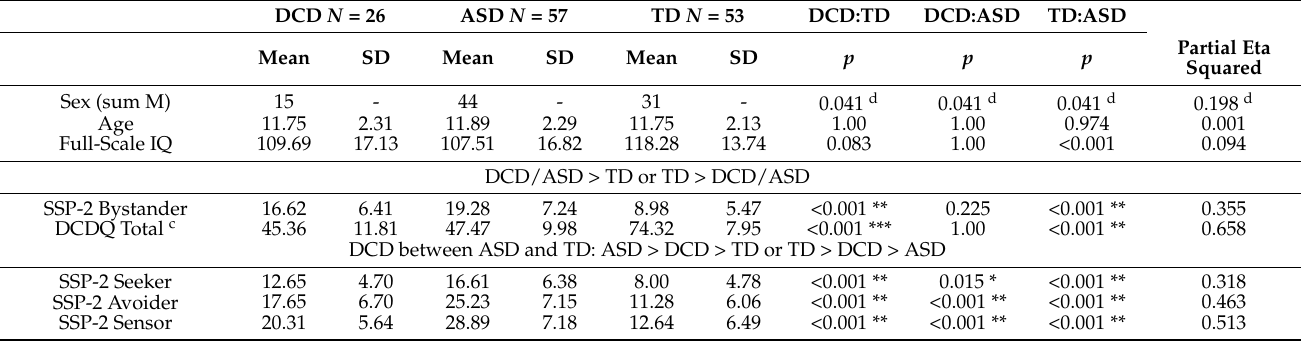
Table 1. The means, standard deviations, p values, and partial eta squares for each group with between-group comparisons for demographic and variable information controlling for age, gender, and